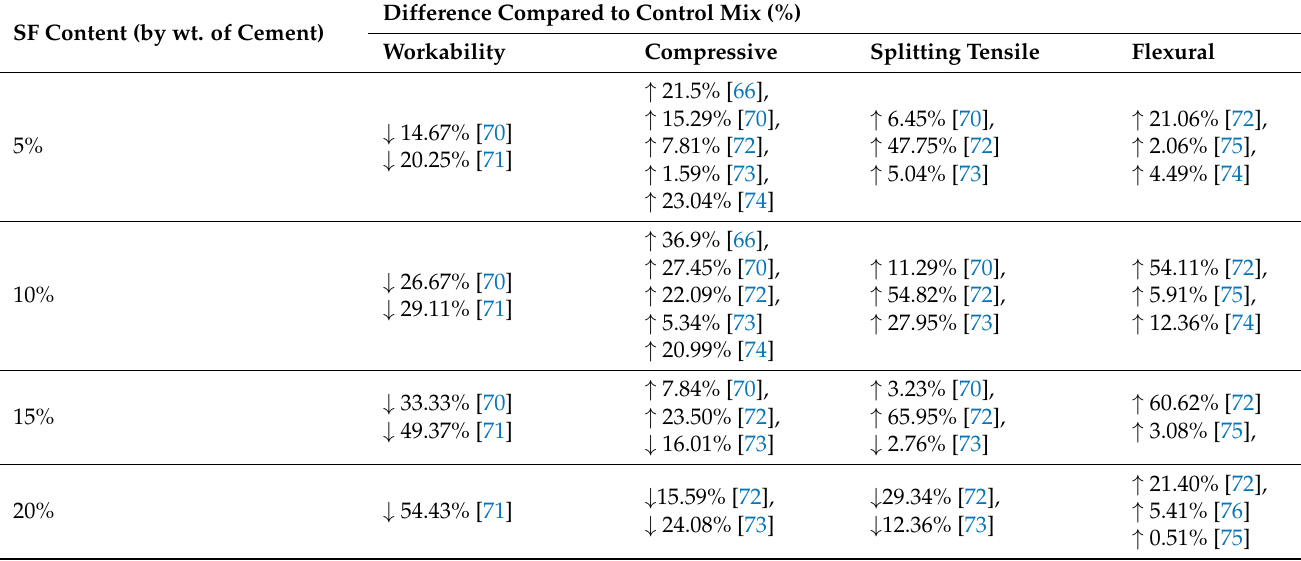
Table 3. Effect of SF on flow and strength properties of cement